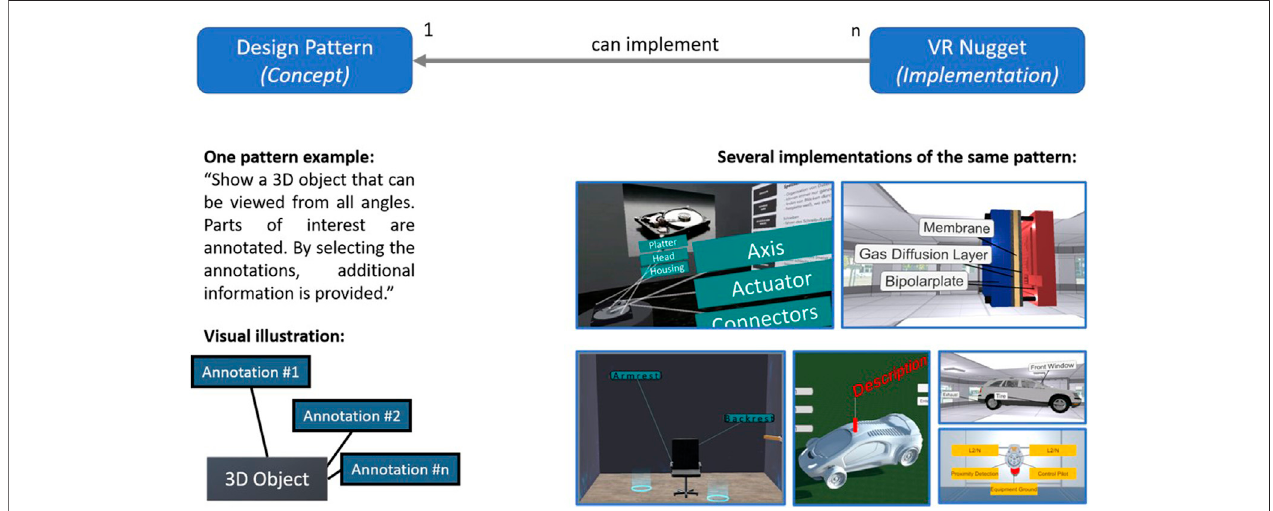
FIGURE 6 | The relation of a pattern and a VR nugget. Several VR nuggets can implement a single pattern. For example, a VR nugget based on a pattern that is used for annotating components of a 3D model in VR may describe different parts of a fuel cell. However, we could also use the same pattern to implemented a VR nugget where components of a hard-drive, a car, or an SAE J1772 charger plug are annotated.